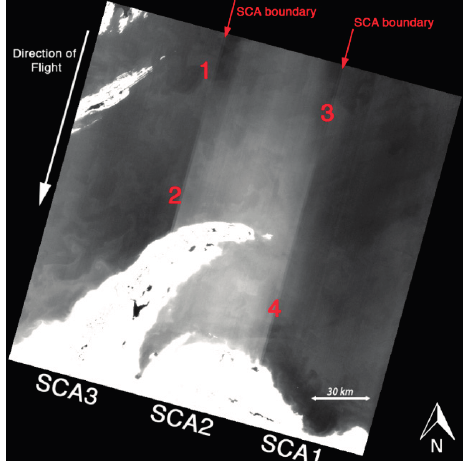
Figure 7. TIRS Band 11 image of Lake Superior (47.5N, 88W) illustrating the discontinuities between the Sensor Chip Assemblies (SCAs) and time-varying nature of the difference. The edges of the SCAs are clearly defined (red arrows) and the differences between the SCAs change from north to south in the image. In a stable system, even with a calibration error, the differences between the SCAs should remain constant for the length of the lake. However, in this example, SCA3 is warmer than SCA2 by 0.2 K at the region marked 1 but is cooler by 0.8 K at region 2. SCA1 is warmer than SCA2 by 0.2 K at region 3 but cooler than SCA2 by 0.7 K at region